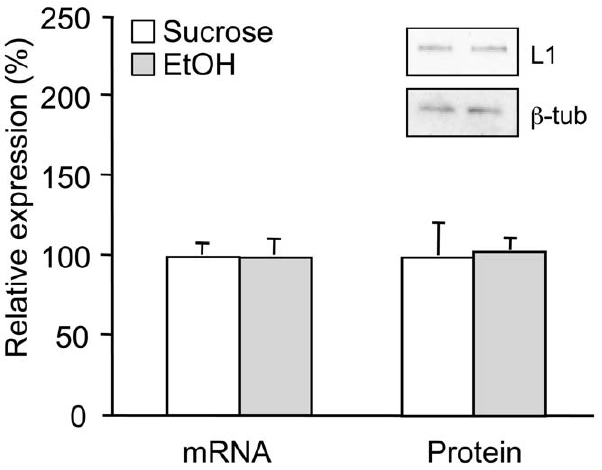
Figure 3. L1 expression in adult cerebellum after chronic binge drinking. Total RNA and tissue lysates were collected from cerebella of adult rats following one year of self-administration of ethanol (2% sucrose/10% ethanol) or sucrose (2% sucrose). L1 mRNA expression was measured by qRT-PCR and normalized to 18S. L1 protein levels were measured by Western blot and normalized to b -tubulin. The inset shows representative Western blot images above corresponding bars. Bars represent normalized mean + SEM (ethanol, n=6; sucrose,